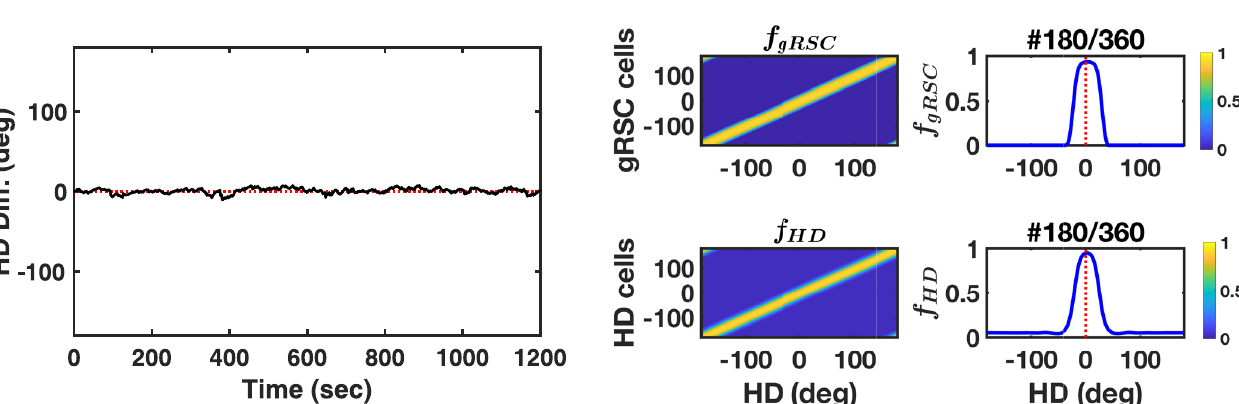
Fig 6. dRSC signals stabilize global subcortical HD signals for the simulation in Fig 5. (A) Simulation in darkness (left, no visual inputs resulting in no feedback from dRSC) shows systematic drift. The HD representation (left, red curves) and its angular difference from actual HD (right, black curves with actual HD subtracted from HD representations) are given over the whole 20-minute learning time. Red dashed lines indicate an ideal error-free HD representation. (B) Simulations of alternating exploration over the multi-environment case in Fig 5A showing stable HD representation (left), as well as global representations of gRSC and HD cells after alternating exploration showing no firing field drift (right). Red dashed lines stand for the center of initial HD firing fields. See the caption of Fig 5 for details. Abbreviations: HD: head-directional/head direction; Accu.: accumulated; Rep.: representation; Diff.: difference; gRSC: granular retrosplenial cortex; f : firing